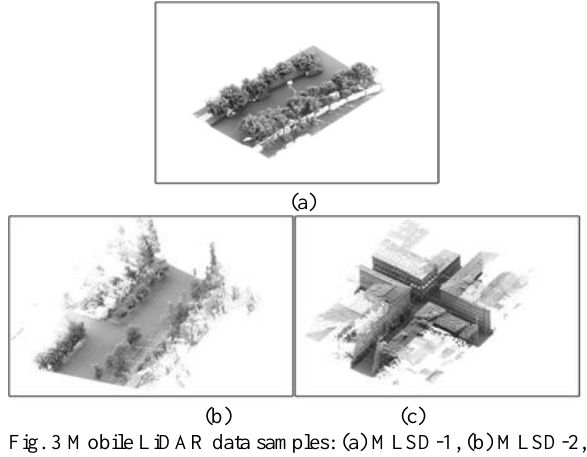
Fig. 3 Mobile LiDAR data samples: (a) MLSD-1, (b) MLSD-2, and (c)